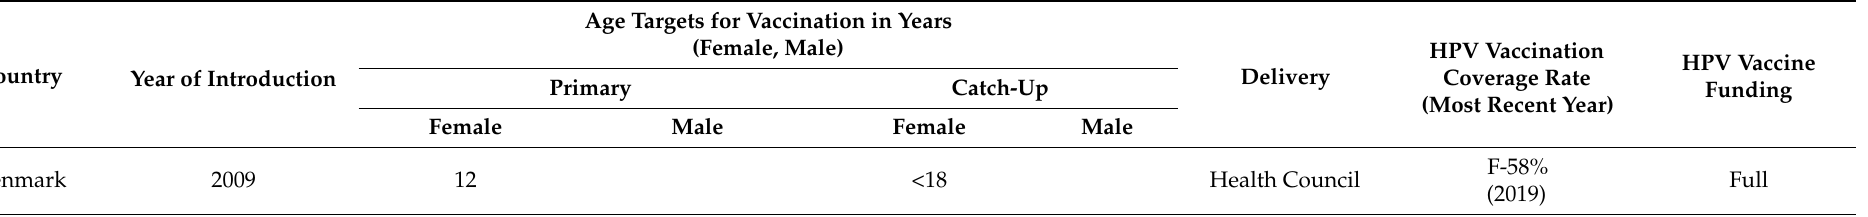
Table 3. Status of HPV national immunization programs in the 10 EU/EEA countries under analysis (Denmark, Greece, Italy, Netherlands, Norway, Poland, Romania, Spain, Sweden, United